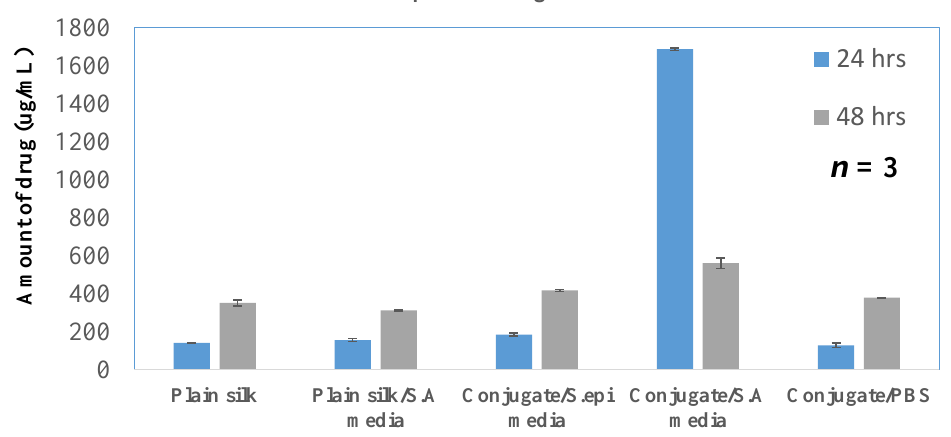
Figure 7. In vitro infection-responsive release of the drug-loaded particles against different